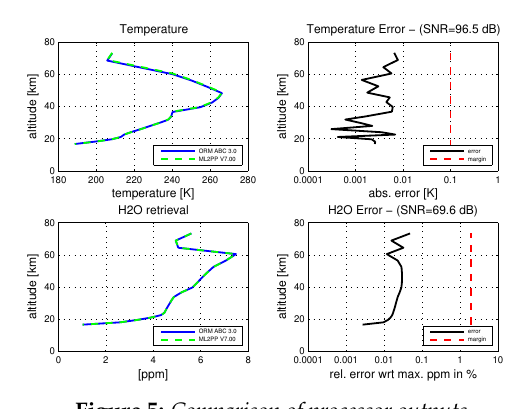
Figure 5: Comparison of processor